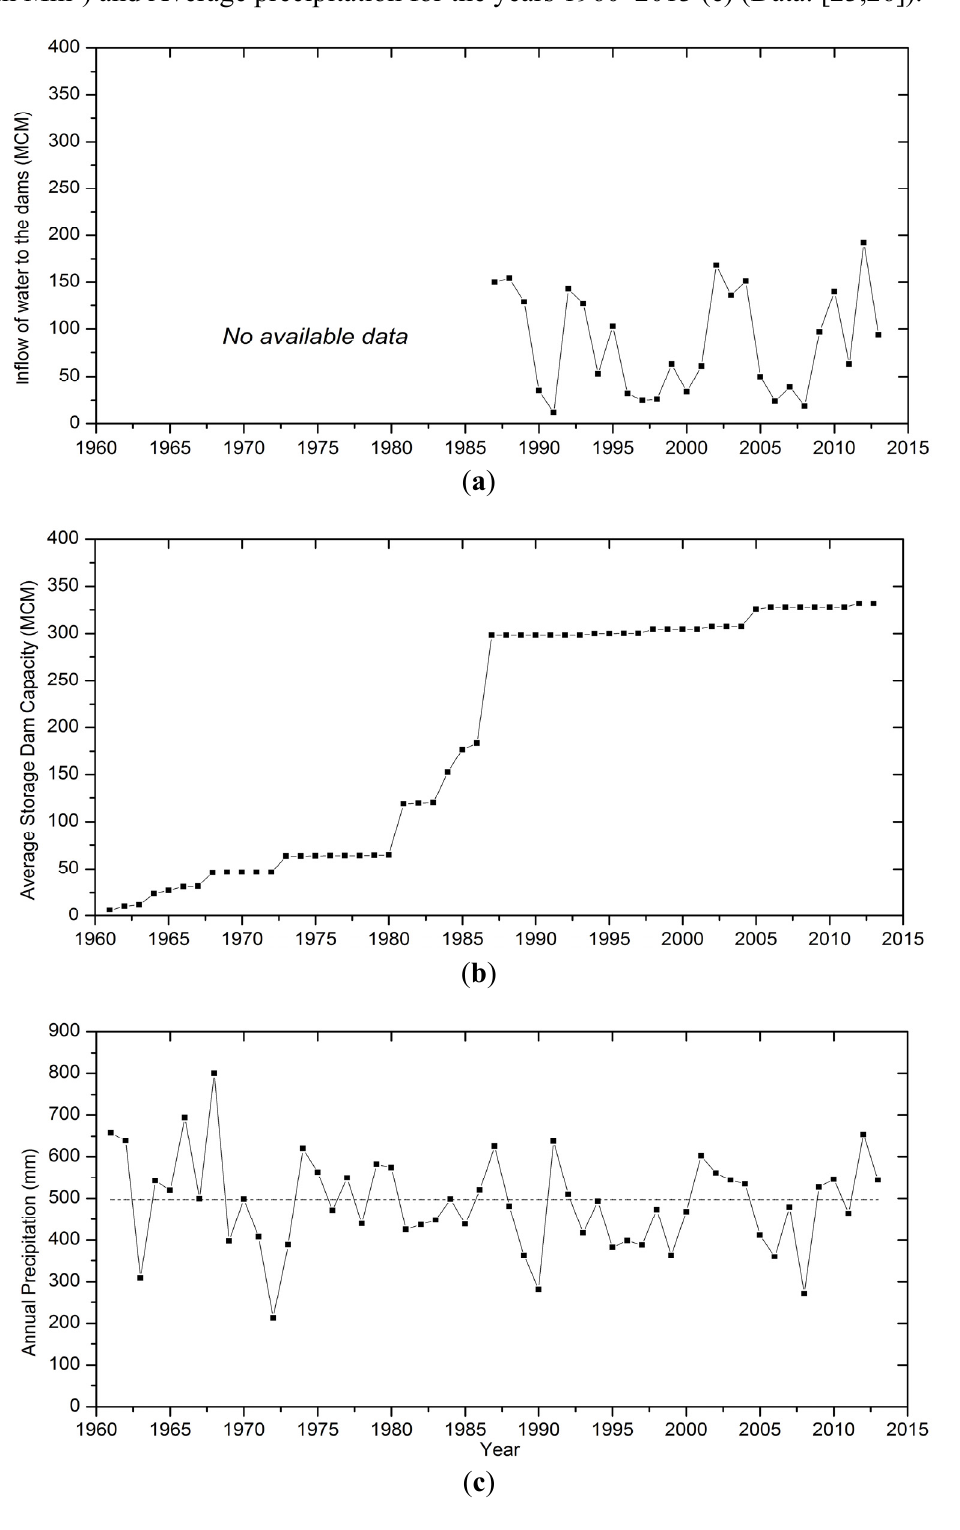
Figure 2. Inflow of Water to the Dams ( a ) vs. Accumulated Storage Dam Capacity ( b ) (both in Mm 3 ) and Average precipitation for the years 1960–2013 ( c ) (Data: